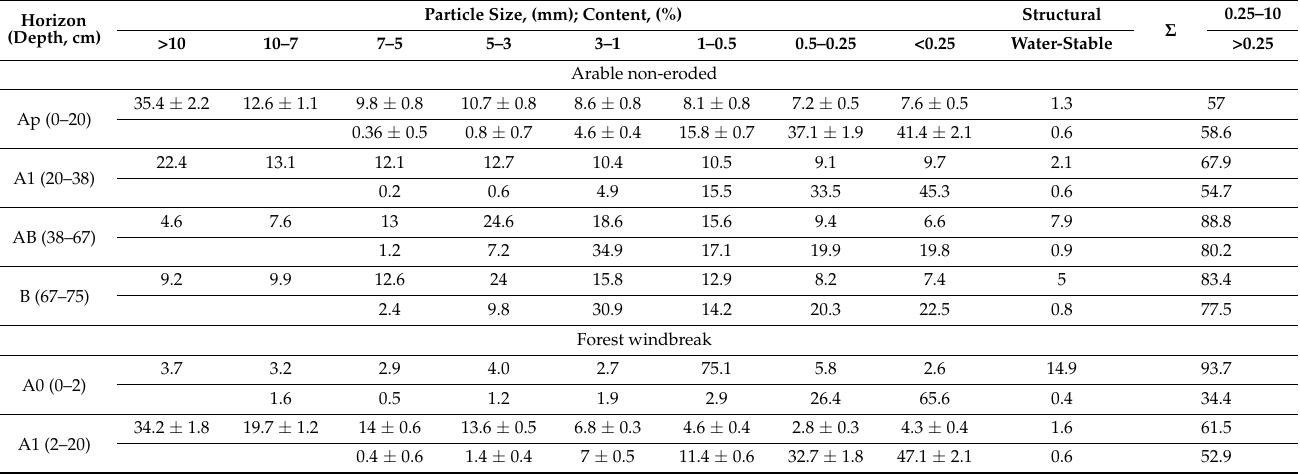
Table 2. The structural and aggregate composition of the soils (mean + SD) 1